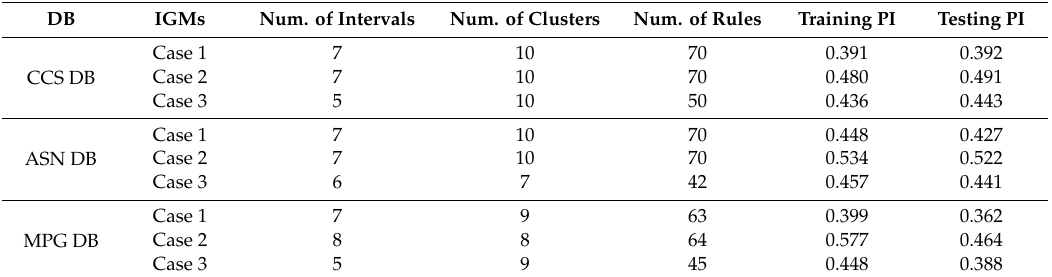
Table 7. CCS prediction result for interval-based IGM (Cases 1, 2, and